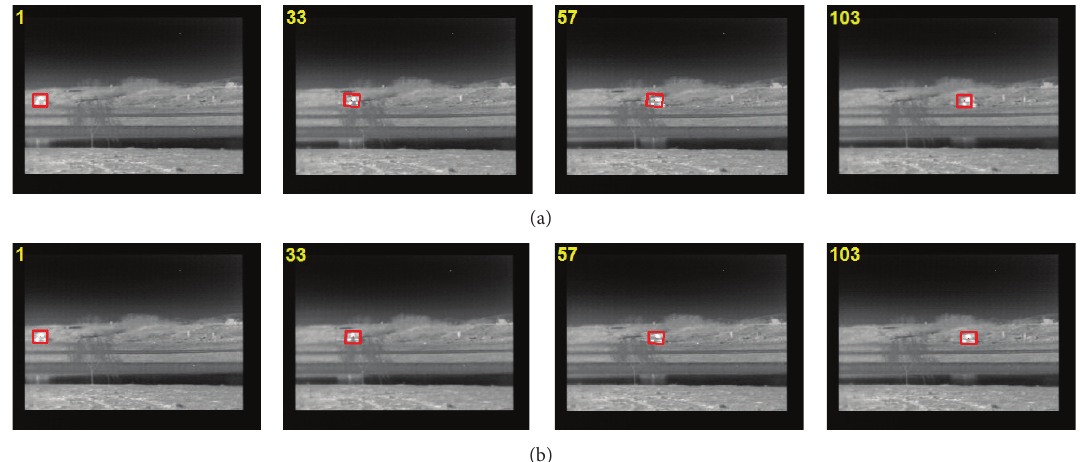
Figure 3: Tracking results for seq.1. The first row: results for IVT. The second row: results for our method.